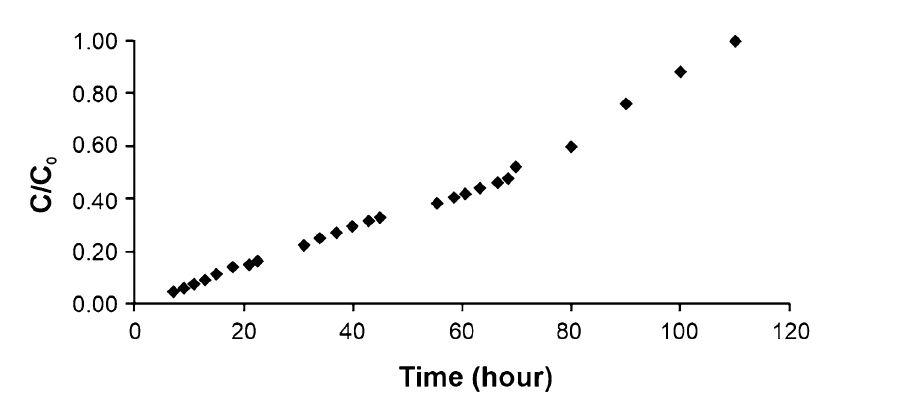
Figure 3. Breakthrough curve for water containing NH 4+ ions. C 0 = initial NH 4+ concentration.